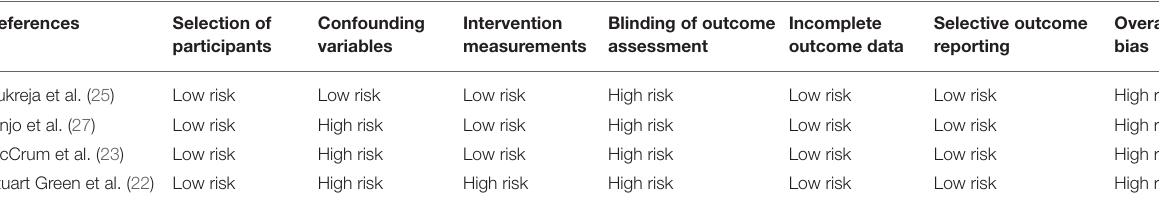
TABLE 3 | Risk of bias in included non-RCTs.